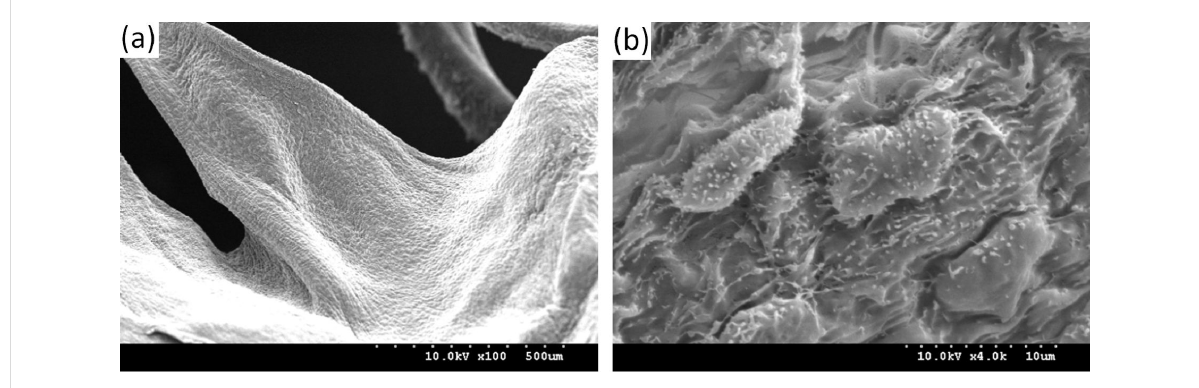
Figure 7: (a) SEM image of the tricuspid valve leaflets of the rabbit; (b) SEM image of the microstructure on the tricuspid valve leaflets surface.